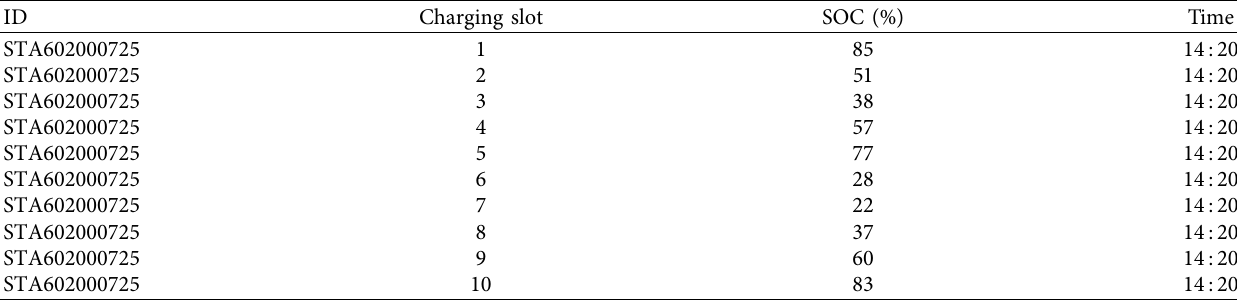
Table 2: An example of the state of charge.